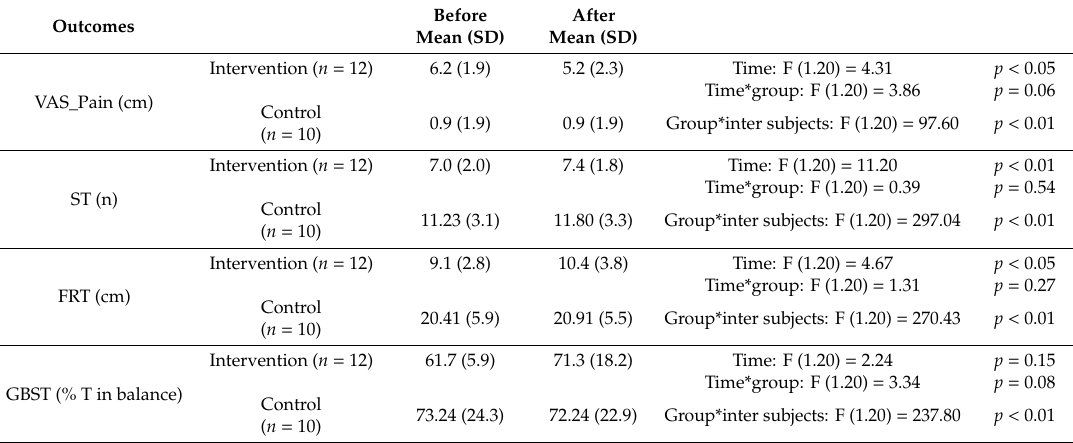
Table 2. Changes due to the immediate e ff ects on pain and balance performance after the aquatic therapy, two-way repeated measures